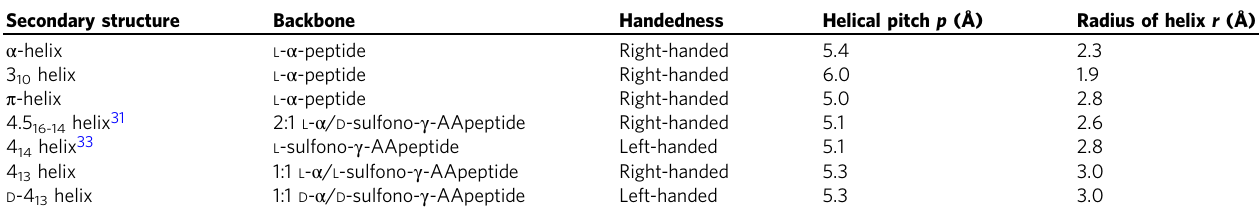
Table 1 Parameters of helical structures found in proteins and foldamers consisting of sulfono- γ -AA peptide hybrids. Secondary structure